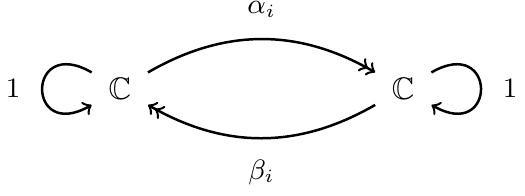
Figure 3 . ~d = (1 ; 1) quiver representation of the